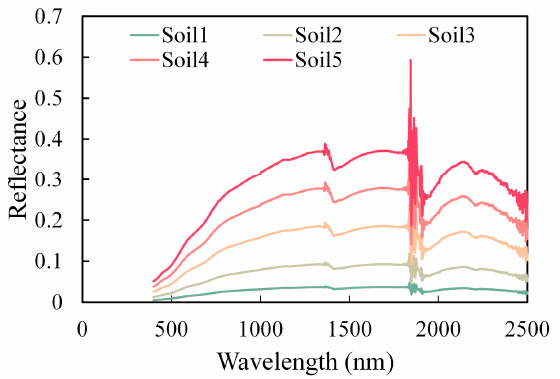
Figure 2. Soil reflectance values used for simulation in the PROSAIL-D model. Table 5. Configuration of the input parameters in the PROSAIL-D model.